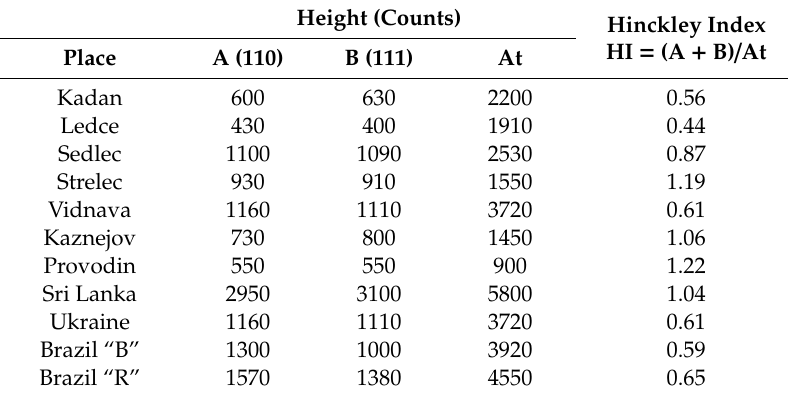
Table 6. The Calculation of the HI index Based on the XRD (2 Θ )